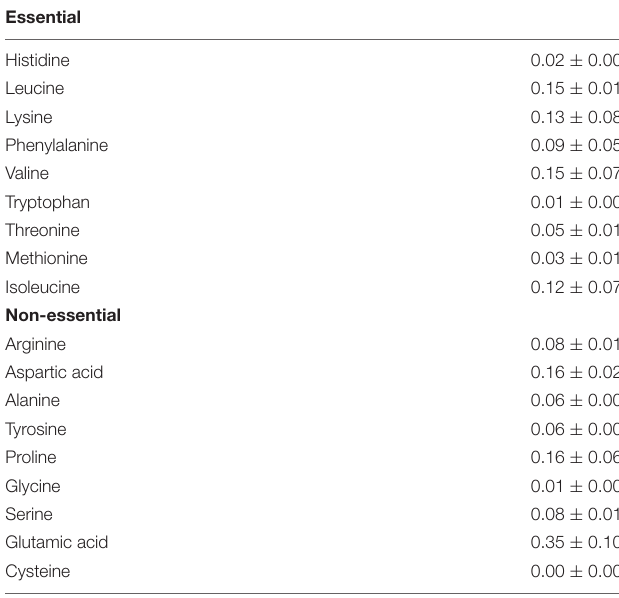
TABLE 2 | Amino acid profile of Zamorano-Leonese milk.